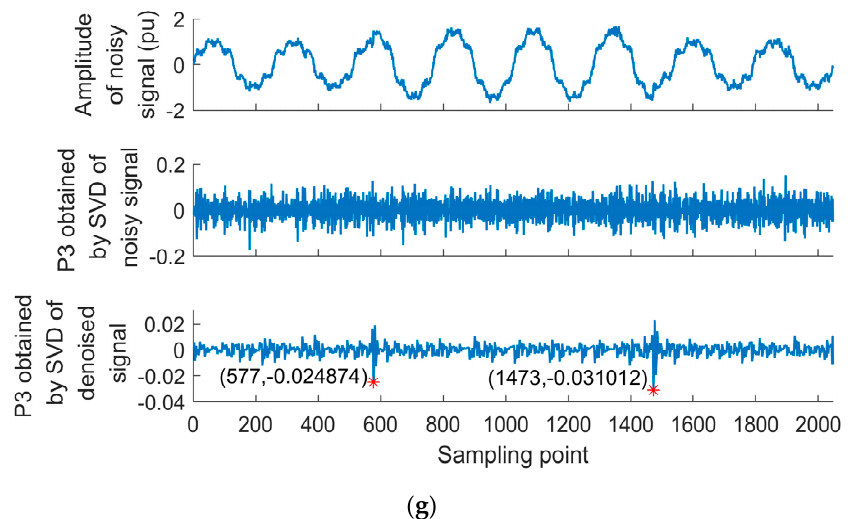
Figure 9. Location results of a variety of transient disturbances with a SNR of 20 dB. ( a ) Voltage interruption; ( b ) voltage sag; ( c ) voltage swell; ( d ) impulsive transient; ( e ) oscillatory transient; ( f ) harmonics with sag; ( g ) harmonics with swell.